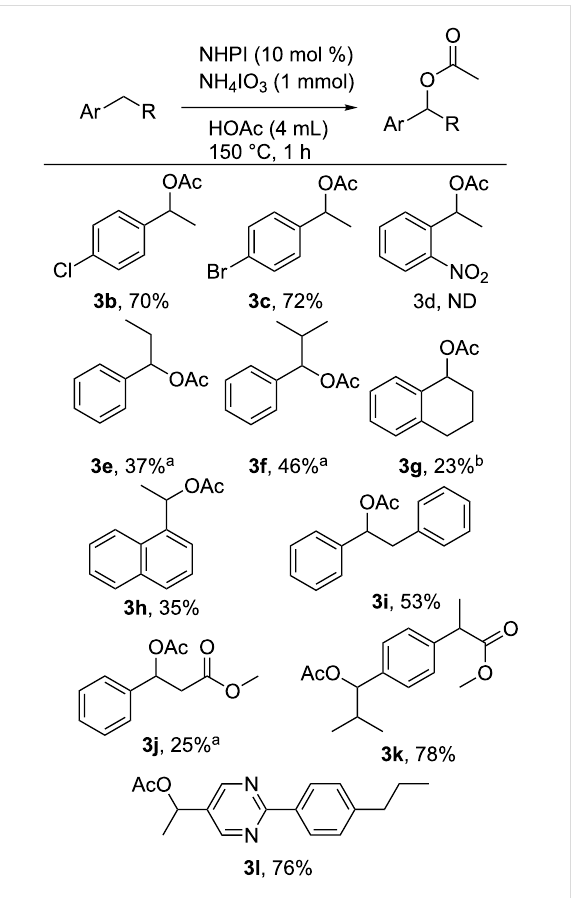
Figure 2: NHPI-catalyzed oxidation of secondary benzylic C–H bonds mediated by iodine(V). a 100 °C for 18 h; b 60 °C for 18 h.